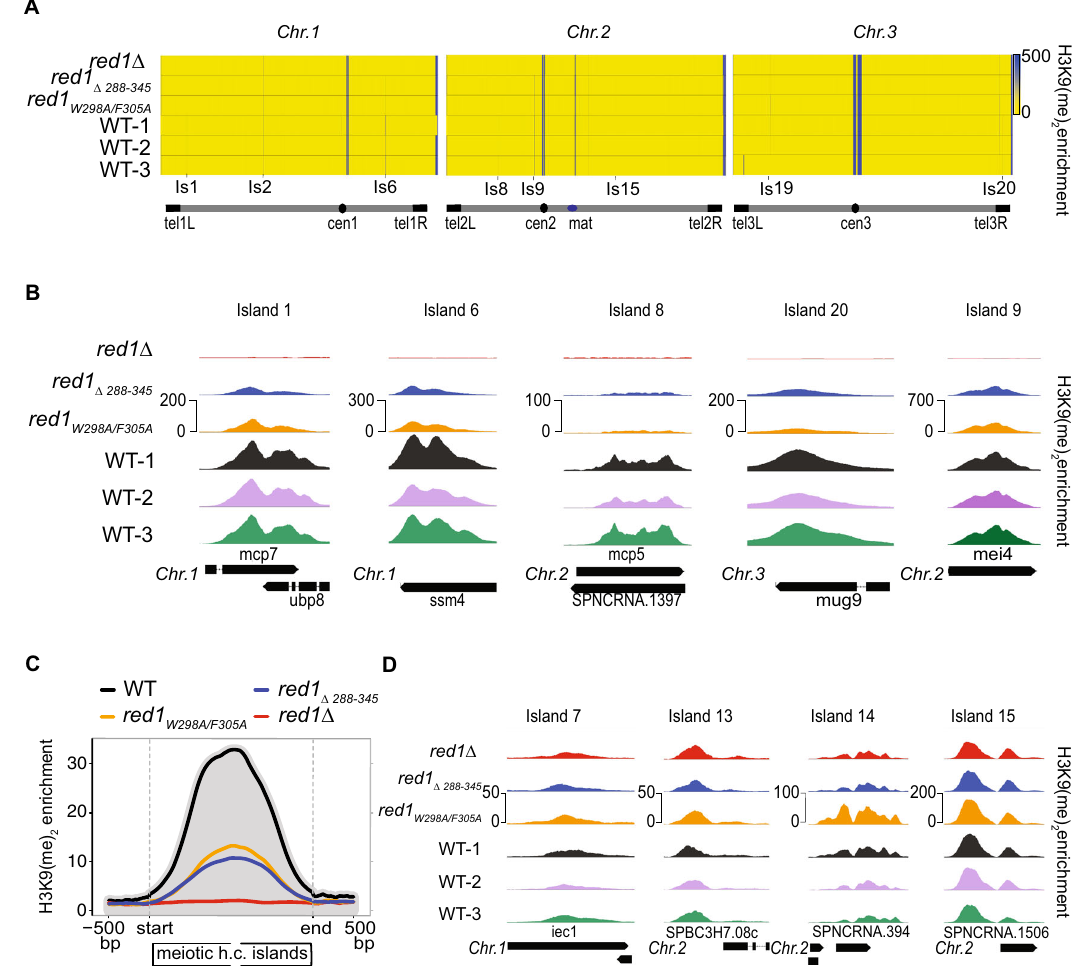
Fig.7|Pla1 – MTRECinteractionisrequiredforef fi cientassemblyoffacultative heterochromatic islands at meiotic genes. A Genome-wide heat-map repre- sentation of H3K9me2 ChIP-seq analysis of three independent WT strains (WT-1 is the isogenic WT strain for the mutants) and red1 Δ , red1 W298A/F305A and red1 Δ 288-345 mutants, showing the H3K9me2 enrichment levels(yellow/blue scale of 0-500)for the 3 chromosomes of the S. pombe genome (length not to scale). Centromeres, Mating-typelocus,telomeresandaselectionoffacultativeheterochromaticislands are indicated. B Representative examples of red1 Δ -sensitive meiotic heterochro- matic islands in WTs and mutant strains are shown in higher resolution (scales are indicated for individual islands). C Average of H3K9me2 enrichment over all